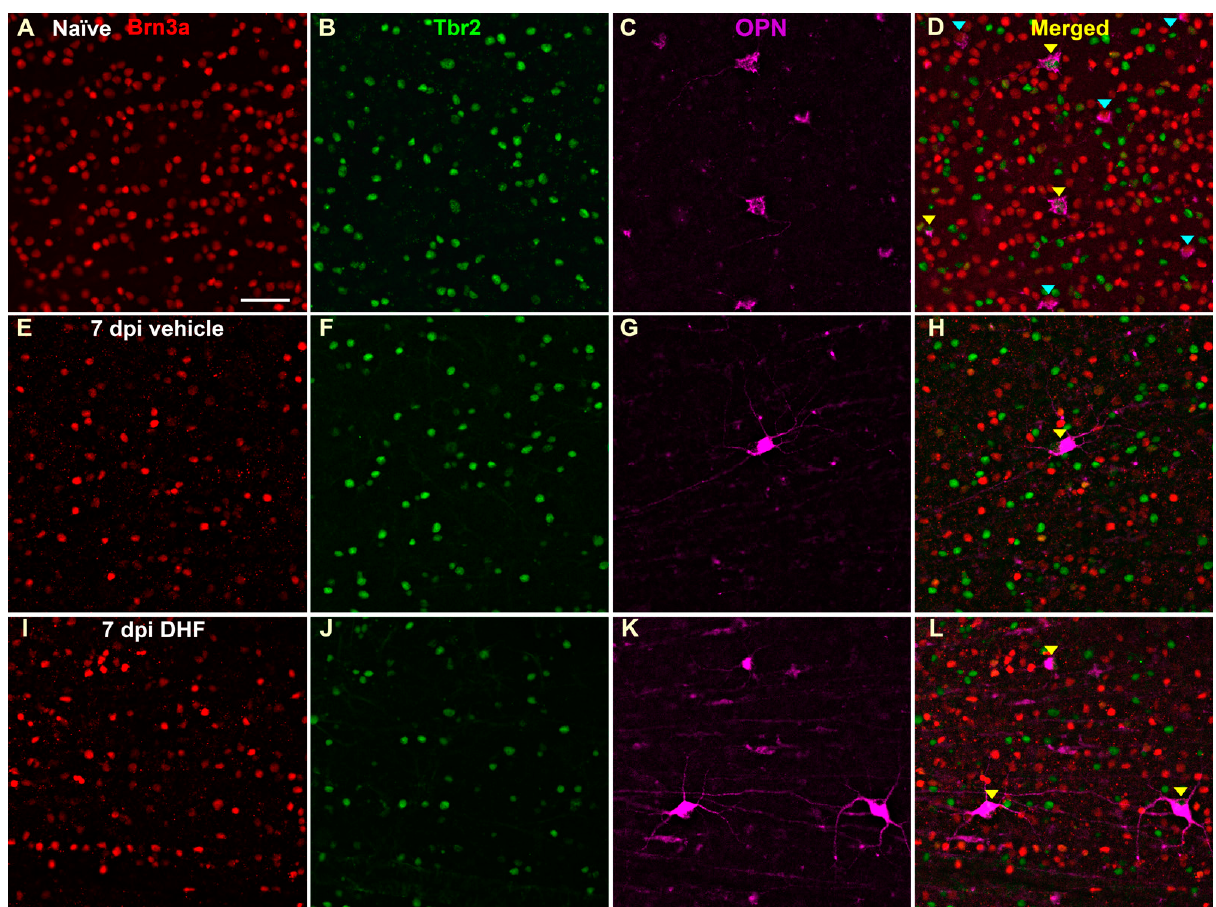
Figure 5. Neuroprotection of axotomized Brn3a + , OPN + and OPN + Tbr2 + RGCs with systemic DHF. Fluorescent micrographs from flat mounted adult albino rat retinas showing brain-specific homeobox/POU domain protein 3A positive retinal ganglion cells Brn3a + RGCs (Brn3a) ( A , E , I ), T-box brain 2 Tbr2 + positive RGCs (Tbr2) ( B , F , J ), osteopontin (OPN) positive OPN + RGCs ( C , G , K ), and merge of these signals ( D , H , L ) in contralateral control ( A–D ) and in experimental retinas